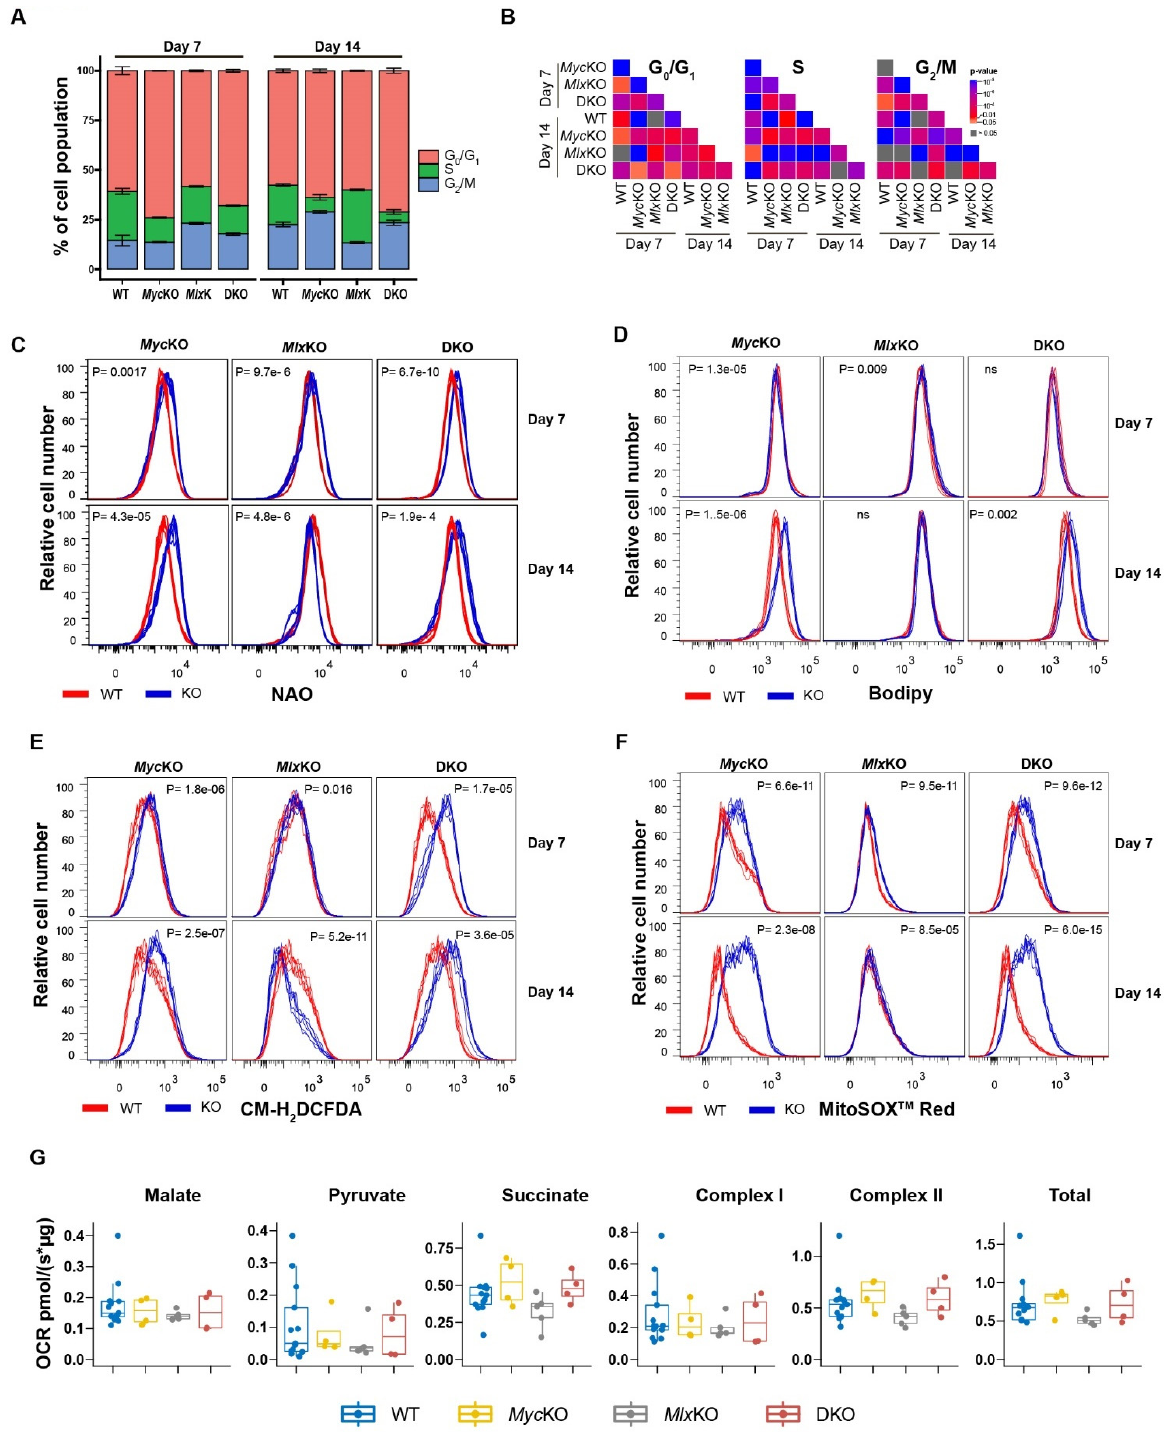
Figure 2. Cell cycle and mitochondrial functional profiling in primary MEFs: ( A ) Cell-cycle analysis. Six replicates of the indicated day 7 and day 14 MEFs were re-plated in the absence of 4OHT, har- vested two days later at ~60% confluence, stained with propidium iodide, and assessed by flow cytometry. The results of each experiment are depicted as histograms, which show the mean fraction of cells in G o /G 1 , S, and G 2 /M ± 1 S.E. ( B ) The percentages of cells in G 0 /G 1 , S, and G 2 /M on day 7 and day 14 shown in ( A ) were compared in order to identify significant inter- and intragroup differ- ences. Gray boxes = not significant. ( C ) Mitochondrial mass of the indicated cell lines on days 7 and